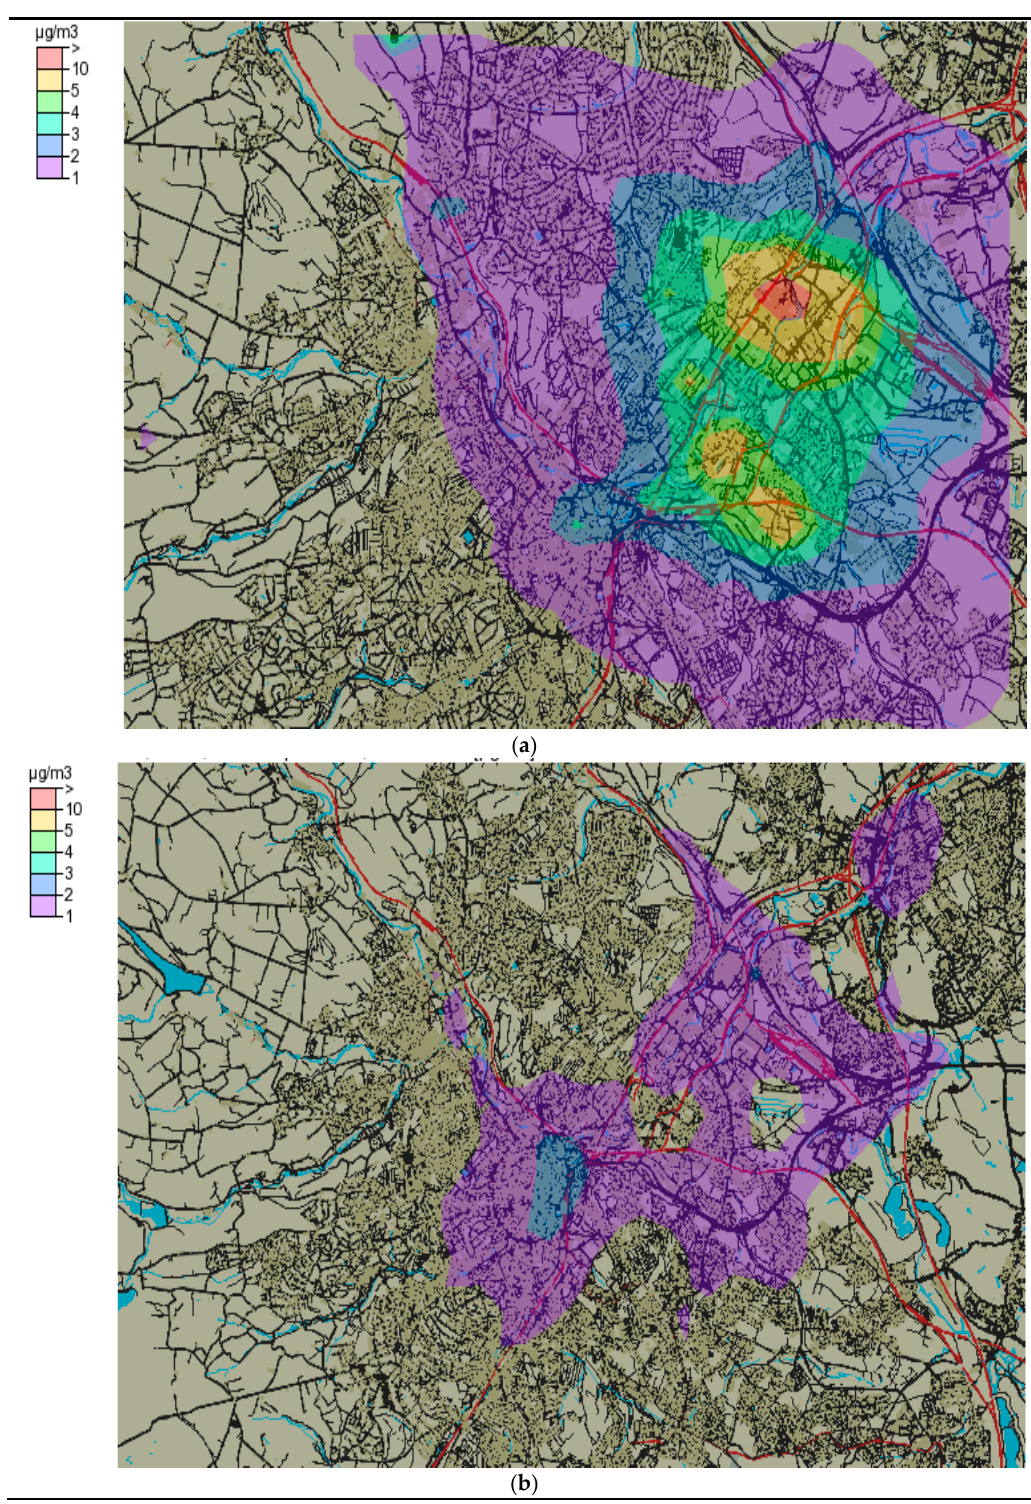
Figure 8. Estimated PM 10 concentrations (µg/m 3 ) from point sources ( a ) and road sources ( b ) in